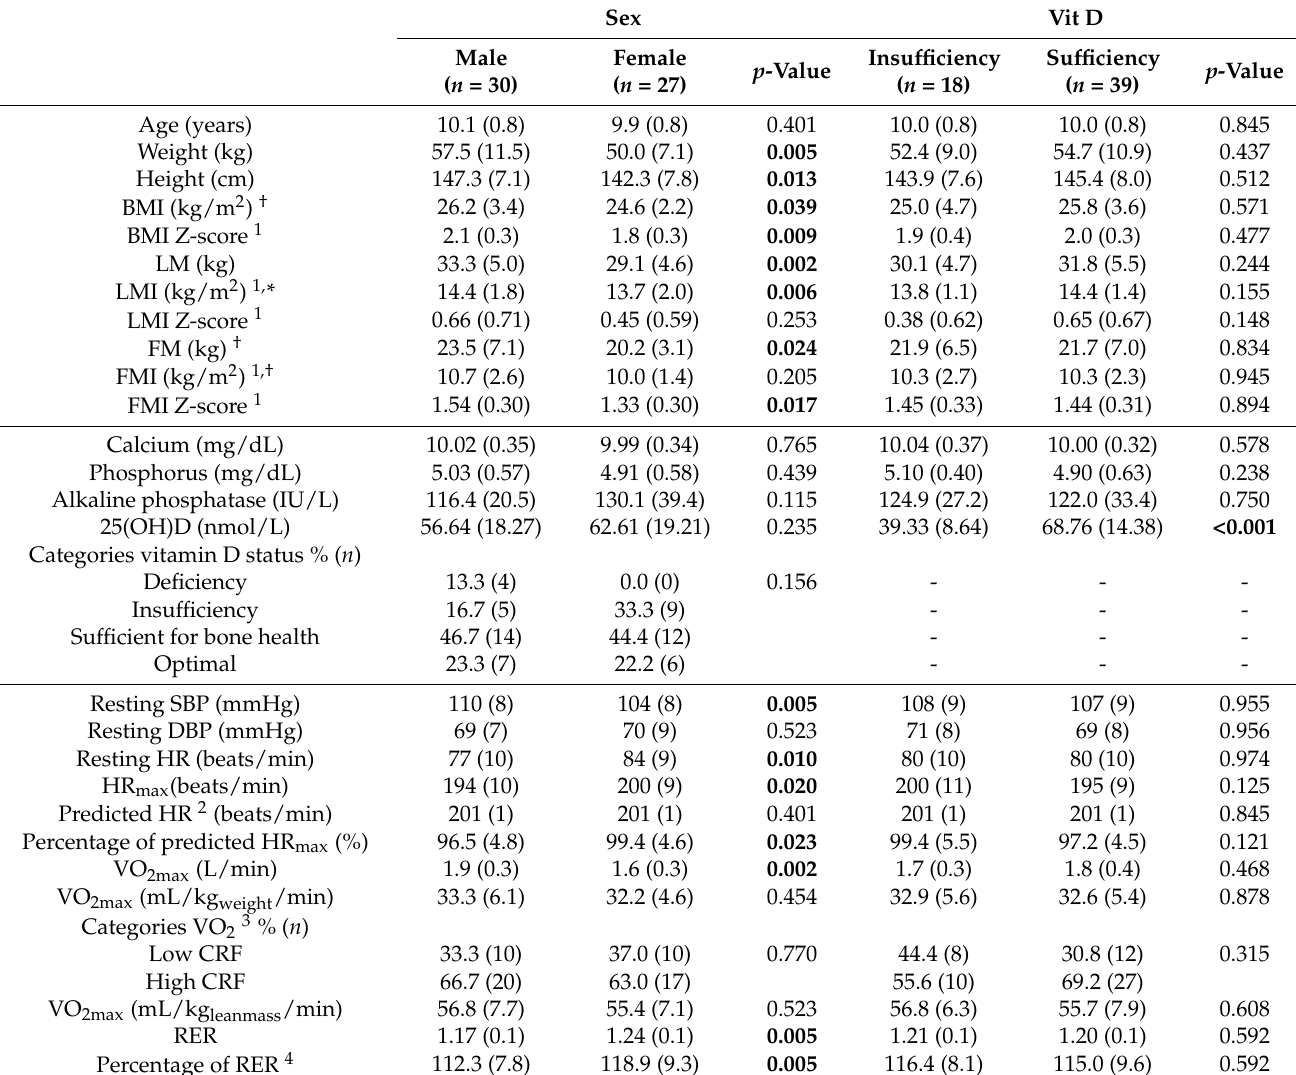
Table 1. Descriptive, biochemical, and cardiorespiratory parameters of the study